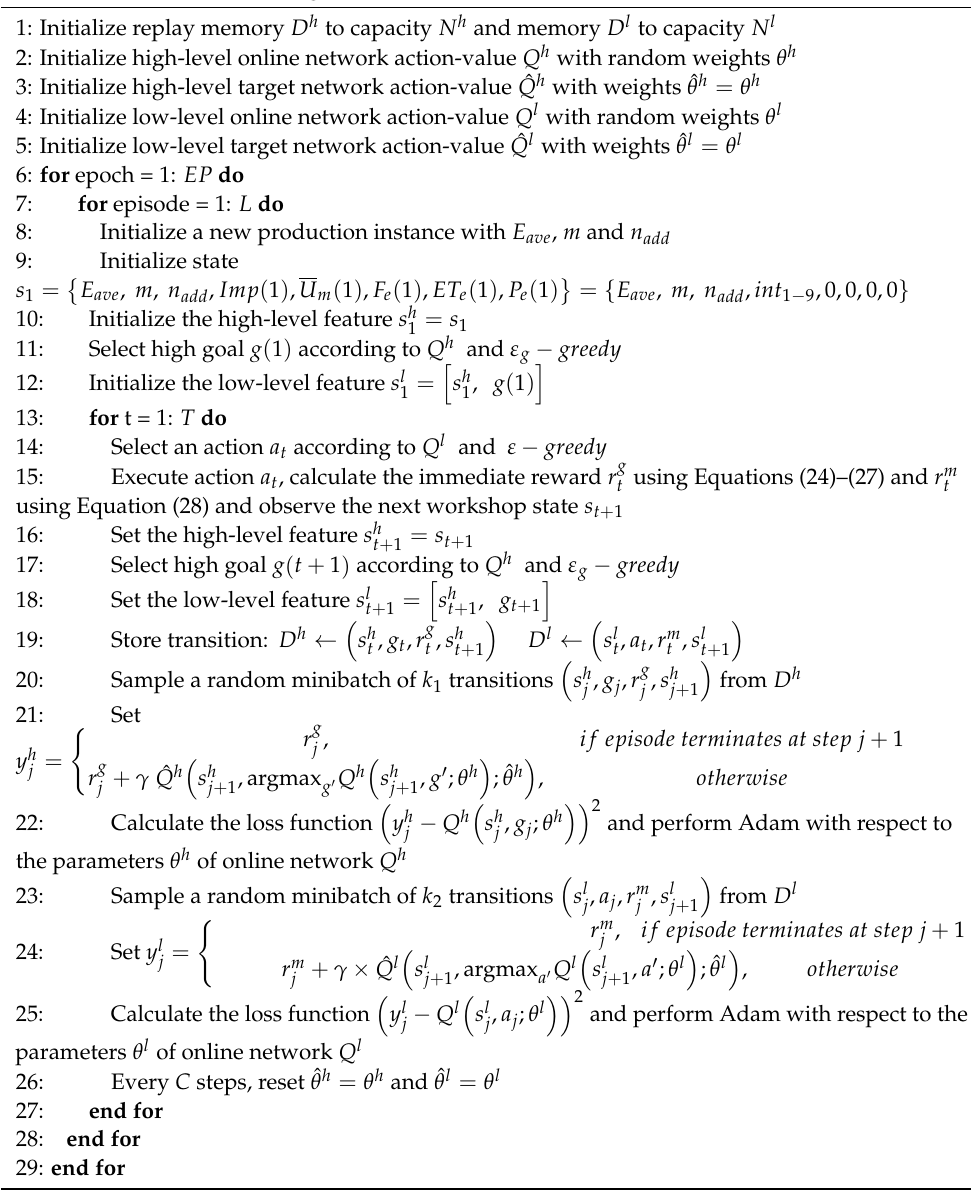
Algorithm 2 The HRL training